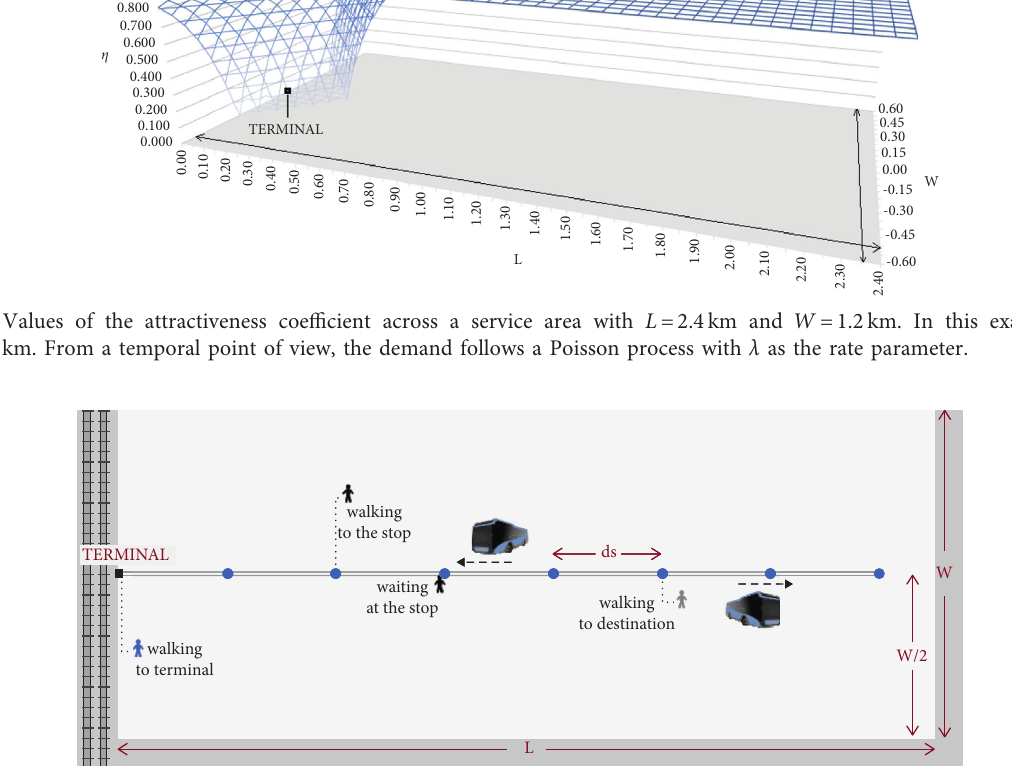
Figure 2: Scheme of the FRF service: users in black are about to take the bus, users in grey got off the bus, and the user in blue is walking directly to the